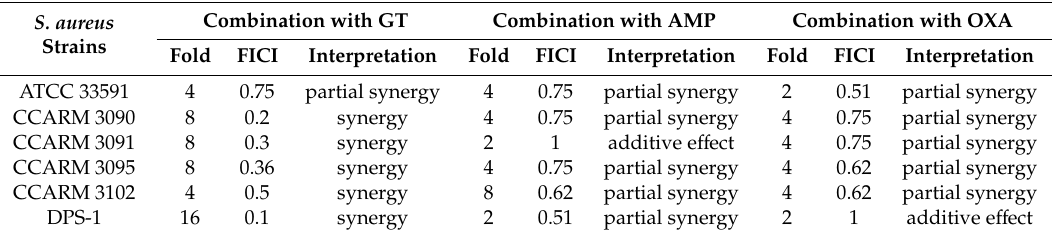
Table 2. The synergy e ff ect of BDMC in combination with